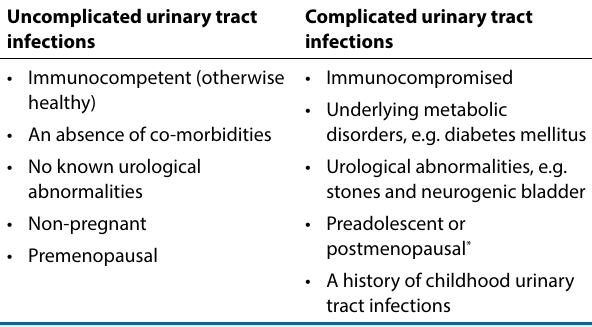
Table I: The characteristics of patients with uncomplicated and complicated urinary tract infections